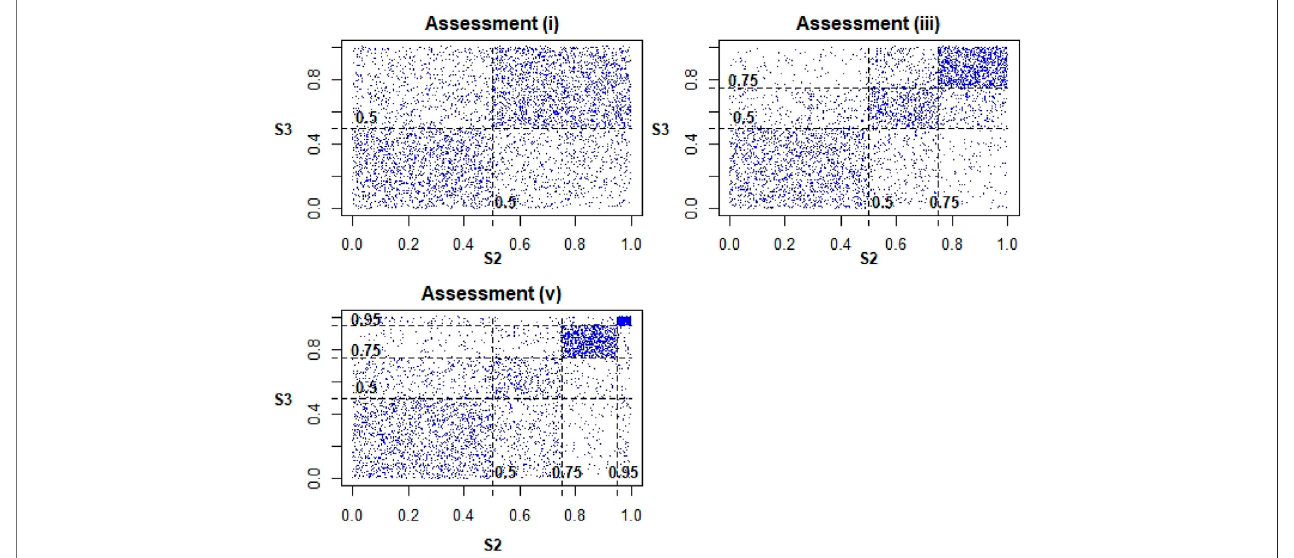
FIGURE 4 | Resulting minimum information scatter-plots when stopping re fi nements after speci fi c assessments for C 2 .